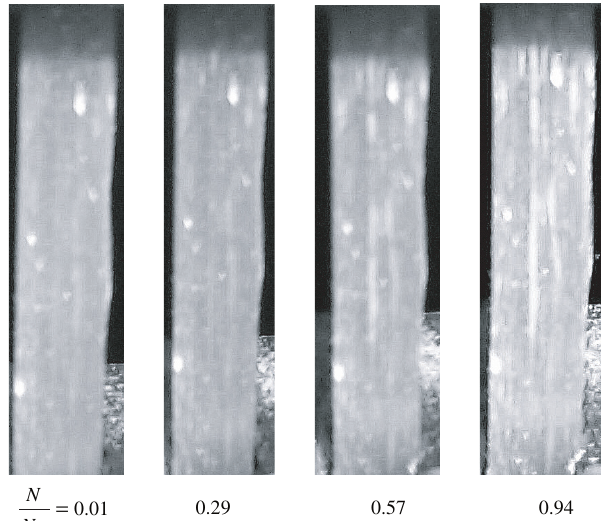
Figure 8. Damage sequence for laminate C10 tested with R = 10 (N = 3500 cycles, σ = 132.8 MPa). 0 max